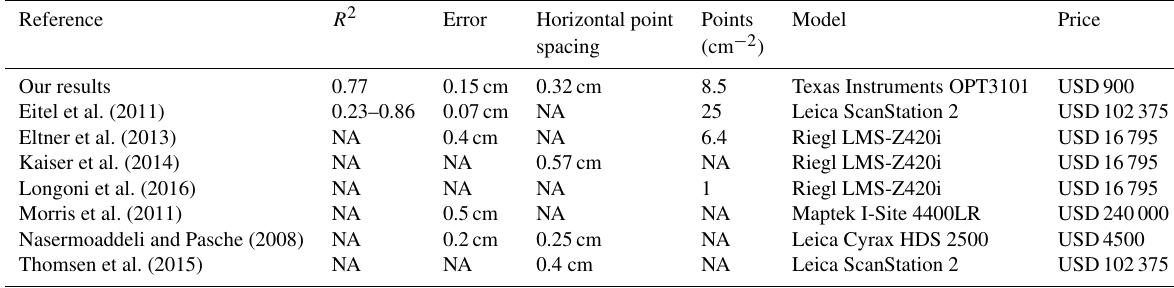
Table A5. Review of studies that used laser scanners for the estimation of surface processes. NA stands for no data available.